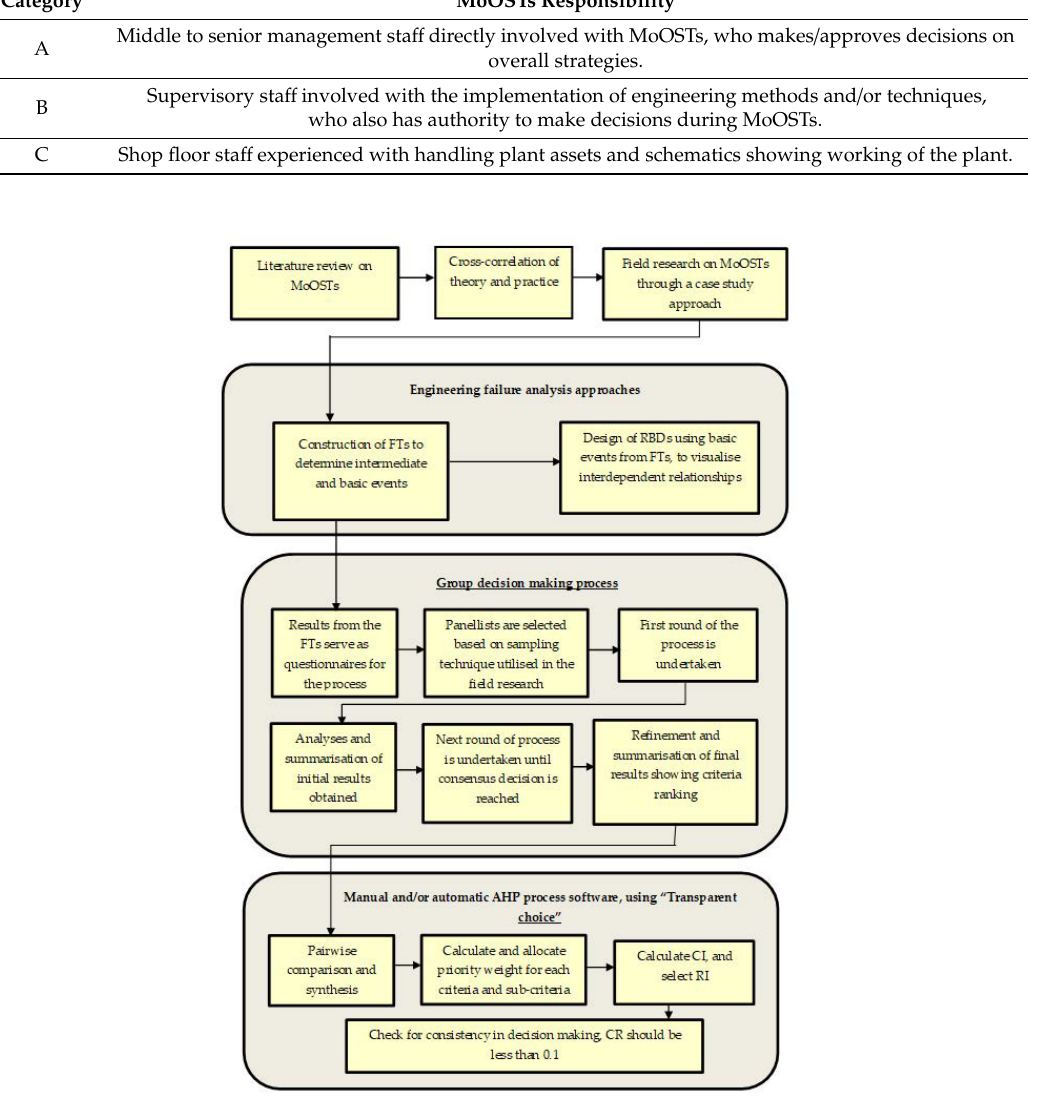
Figure 1. Schematic diagram showing integration of the entire research